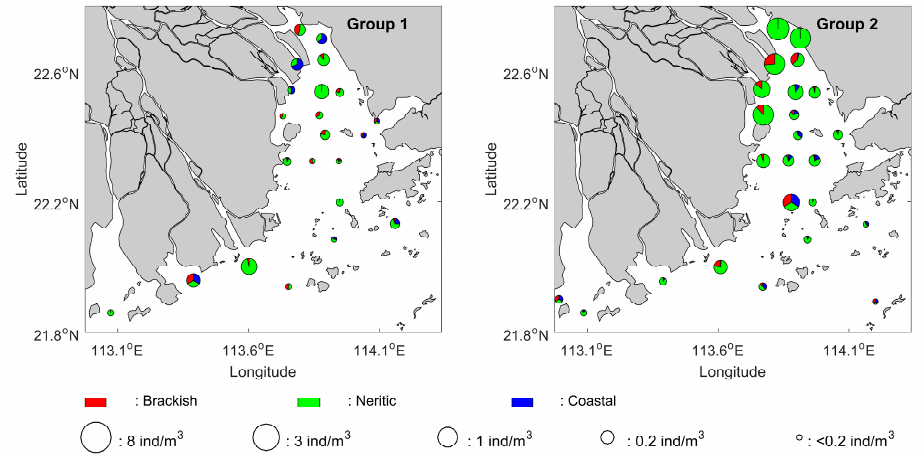
Figure 8. Same as Figure 7 but using the years of groups determined in the dendrogram analysis.